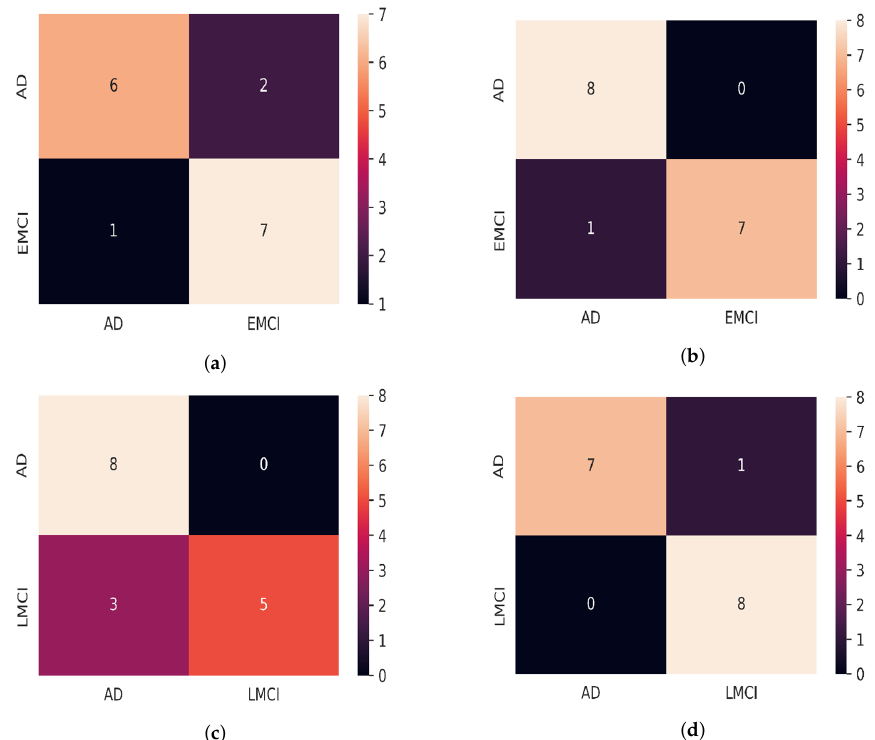
Figure 6. Confusion matrices. ( a ) Confusion matrix for AD/EMCI (MRI test data), ( b ) Confusion matrix for AD/EMCI (PET test data), ( c ) Confusion matrix for AD/LMCI (MRI test data), and ( d ) Confusion matrix for AD/LMCI (PET test